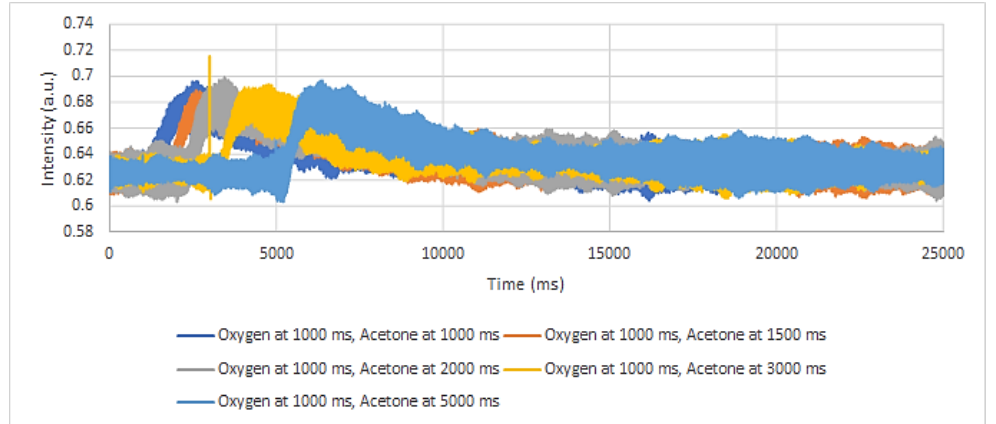
Figure 13. Acetone responses (as probe molecule, from acetone/Ar pulse)) as function of time interval over the 5 mg of catalyst.